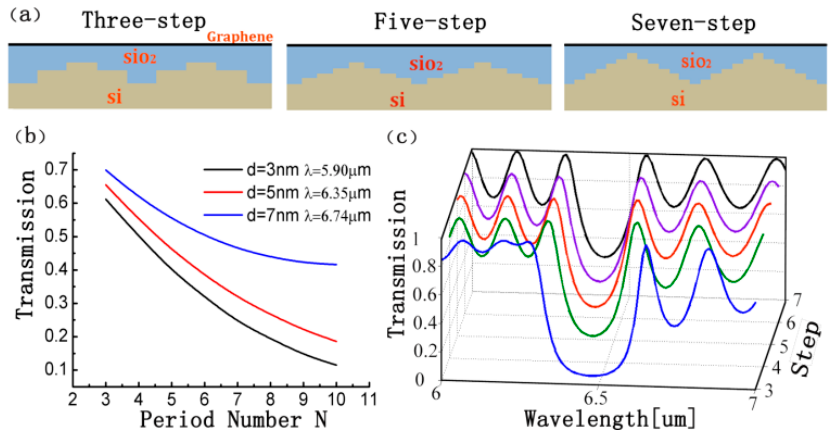
Figure 4. ( a ) The 2D schematic illustration of the PBR unit designed into multiple-step patterns: three-step PBR unit, five-step PRB unit, and seven-step PBR unit, respectively; ( b ) The transmission of the three-step PBR with a different period number N ; ( c ) The transmission of the PBRs for different cases from the three-step to seven-step pattern structures, respectively. Here, d is set as 5 nm, w = 20 nm, the period number N = 6, and the bias voltages V bias = 3.2 V.